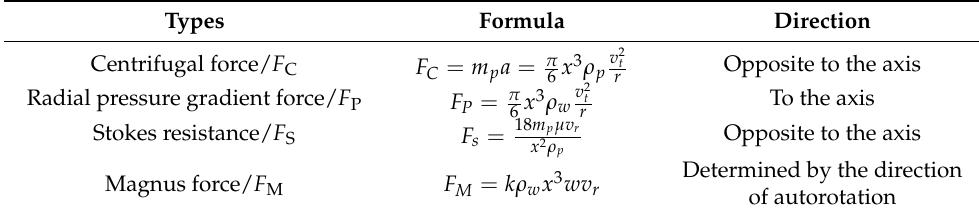
Figure 12. Schematic diagram of the radial force on particles in hydrocyclone. Table 6. Analysis of radial force on particles in